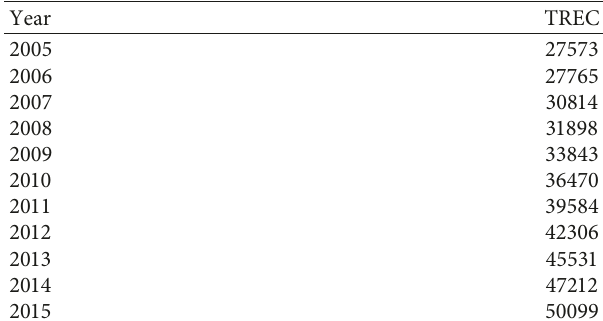
Figure 5: Comparison of the true value and the produced value by different grey models in Example B. Table 10: Raw sequence of China’s total residential energy con- sumption (TREC)